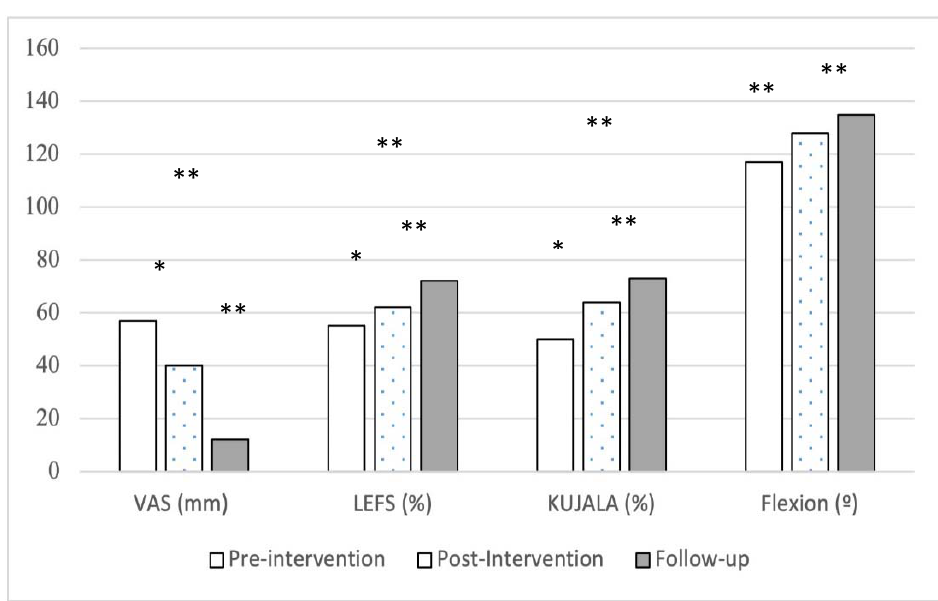
Figure 3. Time per group interaction for VAS, LEFS, Kujala and Flexion range of movement. *: p < 0.05; **: p < 0.001.